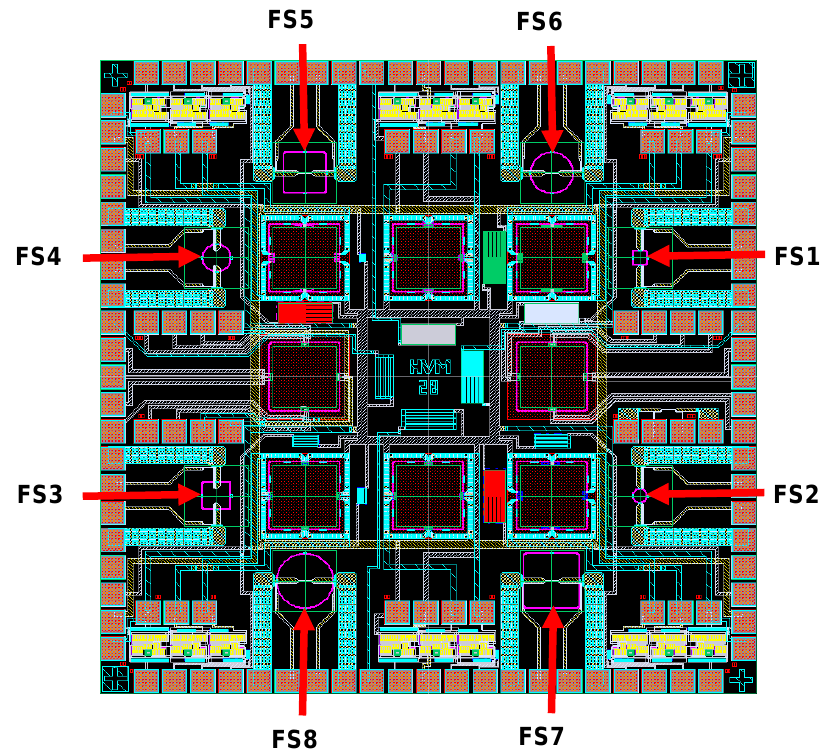
Figure 1. Cadence layout of the MEMS sensor chip which contains eight hot-film thermal flow sensors (FS1 to FS8) in it. The hot-film length is 80 µ m for all eight sensors. However, membrane side length / diameter for FS1 & FS2, FS3 & FS4, FS5 & FS6 and FS7 &FS8 is 80, 160, 240 and 320 µ m, respectively. FS1, FS3, FS5 and FS7 (odd numbers) have square membranes, while FS2, FS4, FS6 and FS8 (even numbers) have circular membranes.